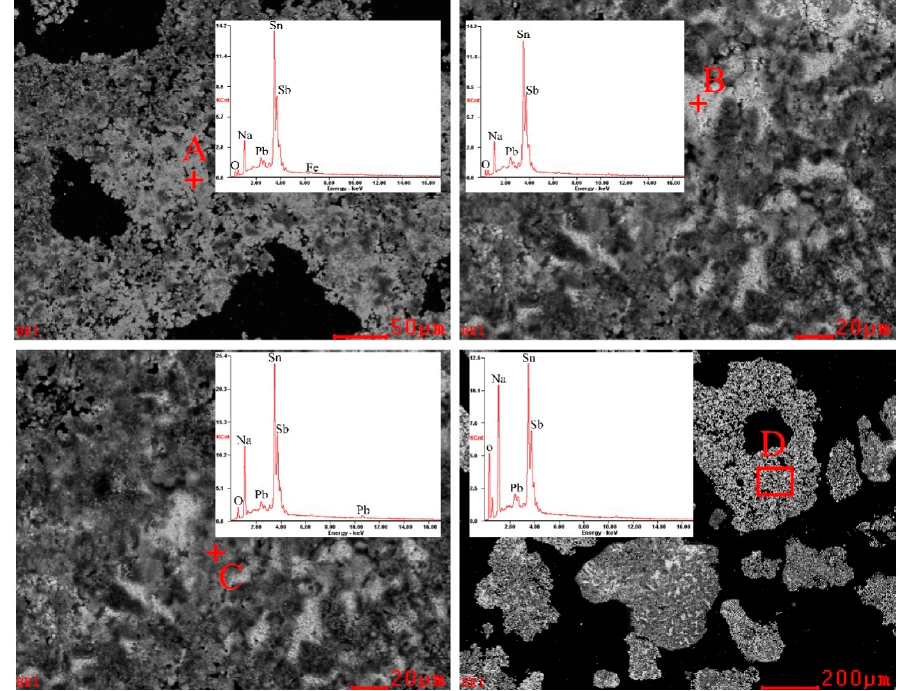
Figure 5. SEM–EDS results of the dross roasted under the optimal conditions: 60% sodium carbonate dosage, temperature 1000 °C, and time 45 min.